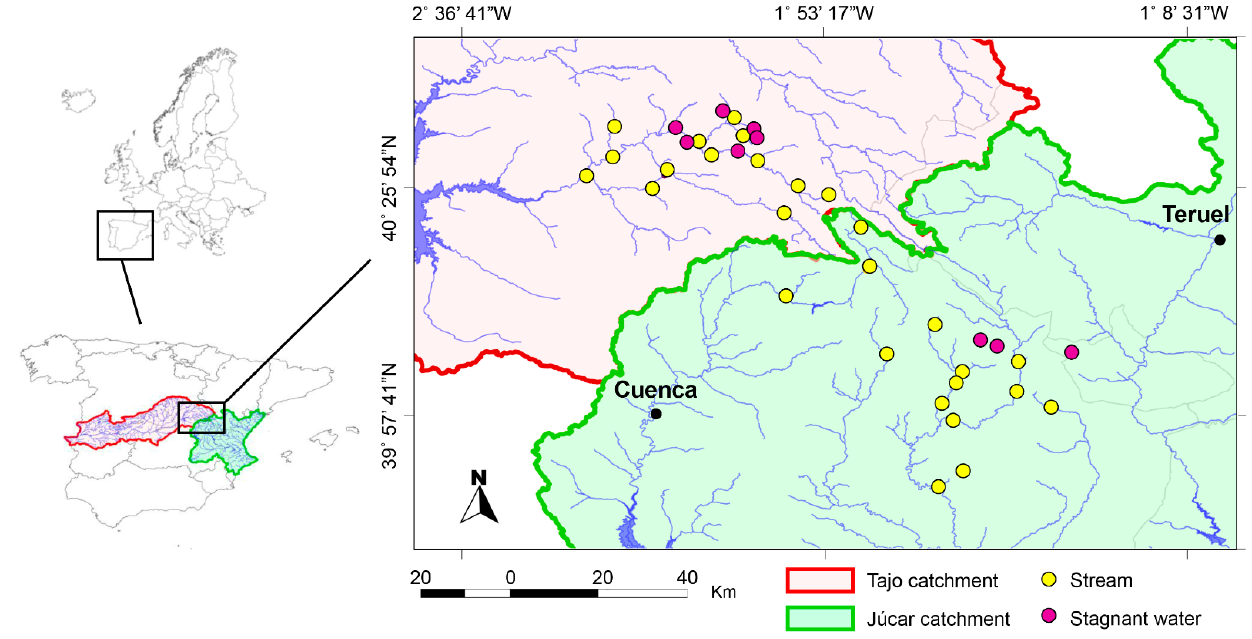
Figure 1. Map of the study area, showing the 36 sampling locations in the higher part of two catchments (Júcar and Tajo rivers; Spain). Stagnant water and stream locations are indicated in different colors. Coordinates and more information on these locations are provided in Table 1 and Table S1 of Supplementary Materials. Table 2. Sampling locations in Serranía de Cuenca (2017). Catchments, coordinates and type of hab ‐ itat (S: stagnant waters, F: flowing waters) are shown.